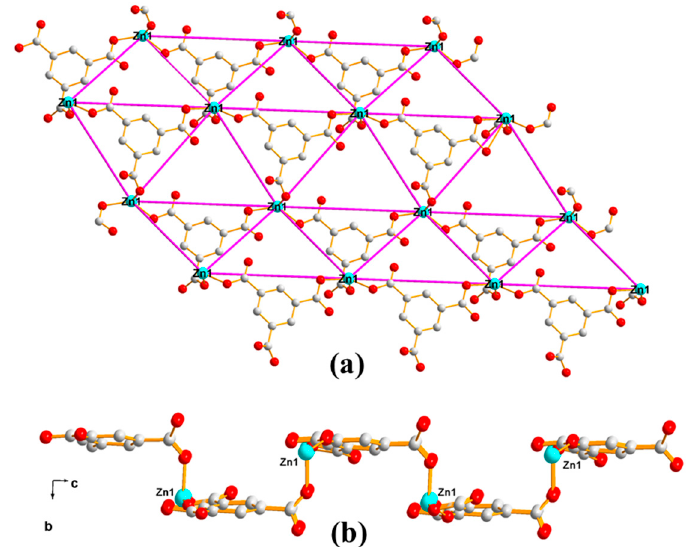
Figure 6. ( a ) Zn1(II) ions connected by the tridentate BTC 3 − ligands, which form a 2D structure of Polymer 2 viewed down the b -axis with the 6-connected net highlighted. ( b ) View down the a -axis of the 2D structure showing a square-wave chain structure, which is highlighted by the red